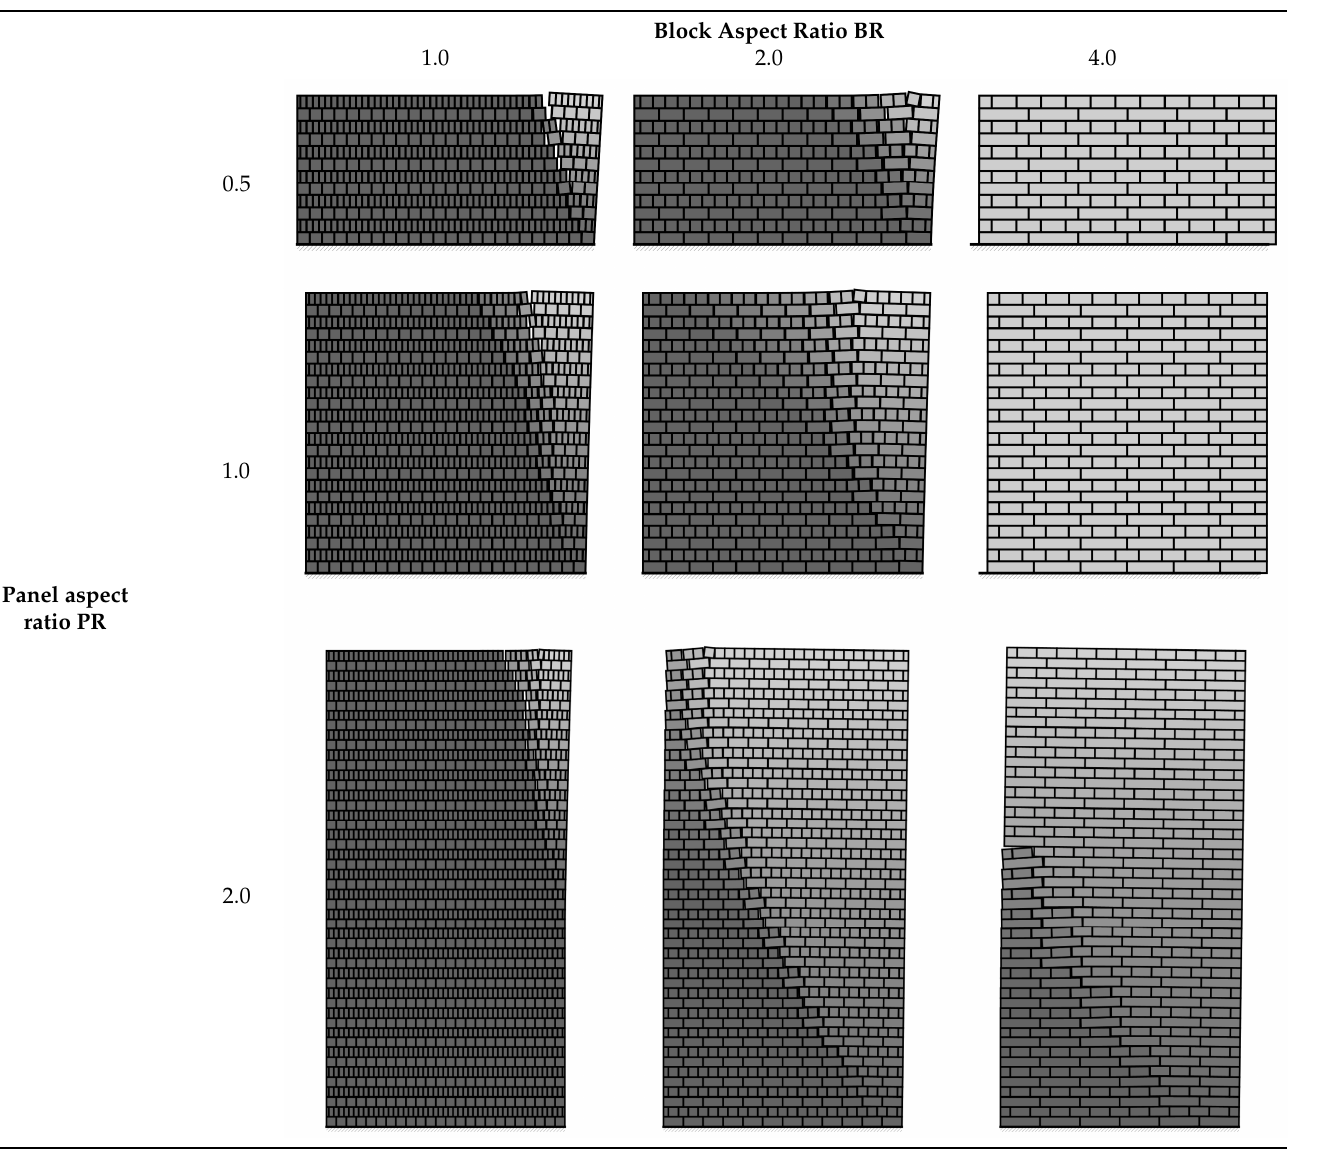
Table A7. Failure Mechanisms for English Bond with µ = 0.50.